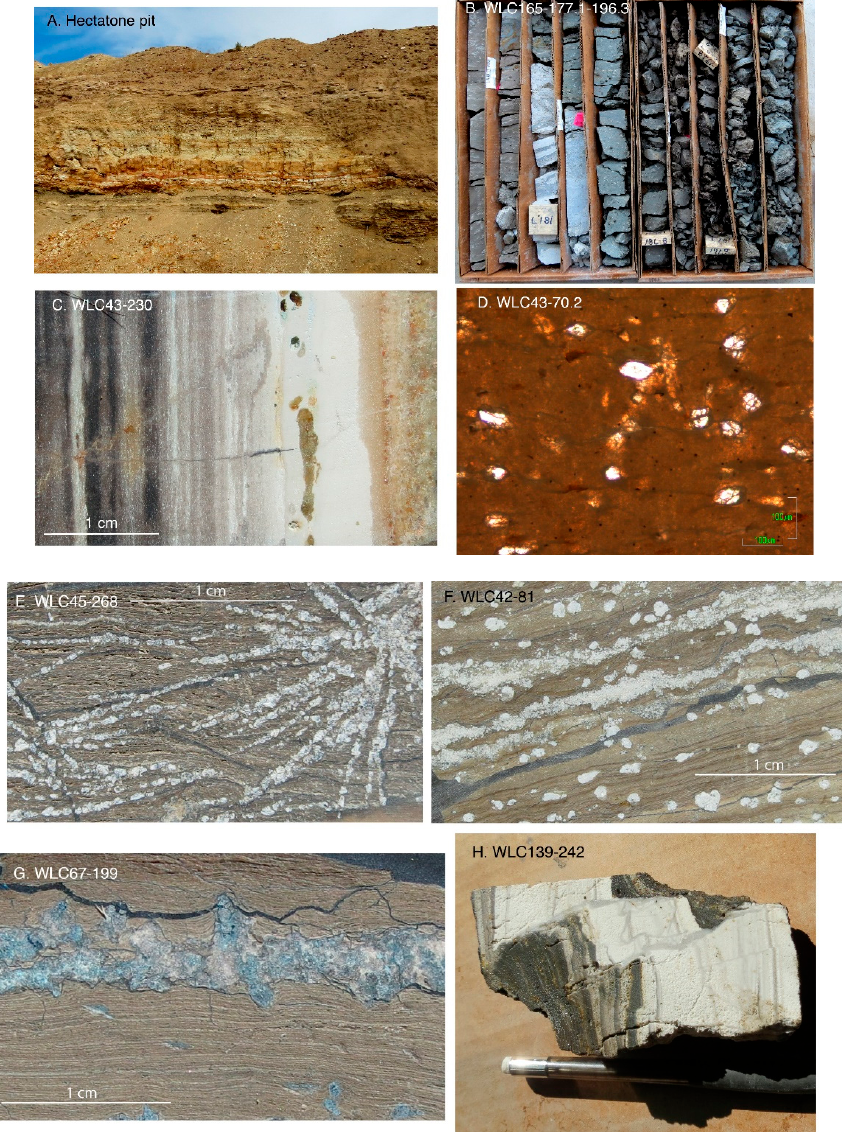
Figure 3. ( A ) 4 m thick exposure of thin-bedded to laminated pale grey to green claystone and white to pale brown tuff overlain by alluvium, Hectatone pit 350 m east of proposed 2011 Lithium Nevada pit. Hammer, 30 cm long, for scale in lower right. ( B ) Core from 177.1 to 196.3 feet (54–60 m) in hole WLC165 showing gray to dark gray claystone with white tuff layers near the 181.7 ft. marker. Core intervals in these boxes range between 5690 and 7390 ppm Li, except interval containing tuff layers which has 1850 ppm Li. ( C ) Highly silicified laminated sediment; brown tuff feldspar-rich layer on right only partly silicified. Core sample WLC43-230.5. 410 ppm Li. ( D ) Mudstone with quartz grains, bitumen, and pyrite. Core sample WLC43-70.2 (21 m depth), plane polarized light, horizontal field = 0.8 mm. 4630 ppm Li. ( E ) Calcite rhombs replacing plate-like crystals in claystone. Original crystals cut across laminae. Core sample WLC45-268 (82 m). 5180 ppm Li. ( F ) Disseminated dolomite crystals and crystalline layers in claystone. Disseminated crystals cut across sedimentary laminae. Core sample WLC42-81.8 (25 m). 4310 ppm Li. ( G ) Fluorite layer in claystone with laminae displaced around fluorite crystals indicating the sediments were soft during crystallization. Core sample WLC67-199.2 (61 m). 6100 ppm Li. ( H ) White tu ff layer in dark gray claystone, displaced by minor faults. White microcrystalline quartz veinlets occur along faults and irregularly in the tu ff . Core sample WLC139-242 (74 m) in high-Li